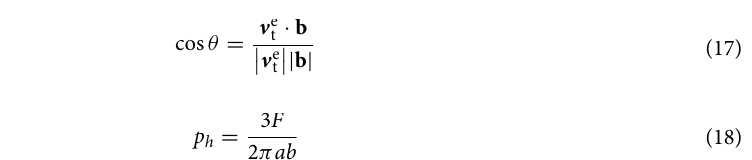
Table 3. Based on the results of LTCA, the contact parameters of the lubrication analysis of the spiral bevel gear are cal- culated. Table 4 shows the contact curvature, load and lubricant entraining velocity at different contact